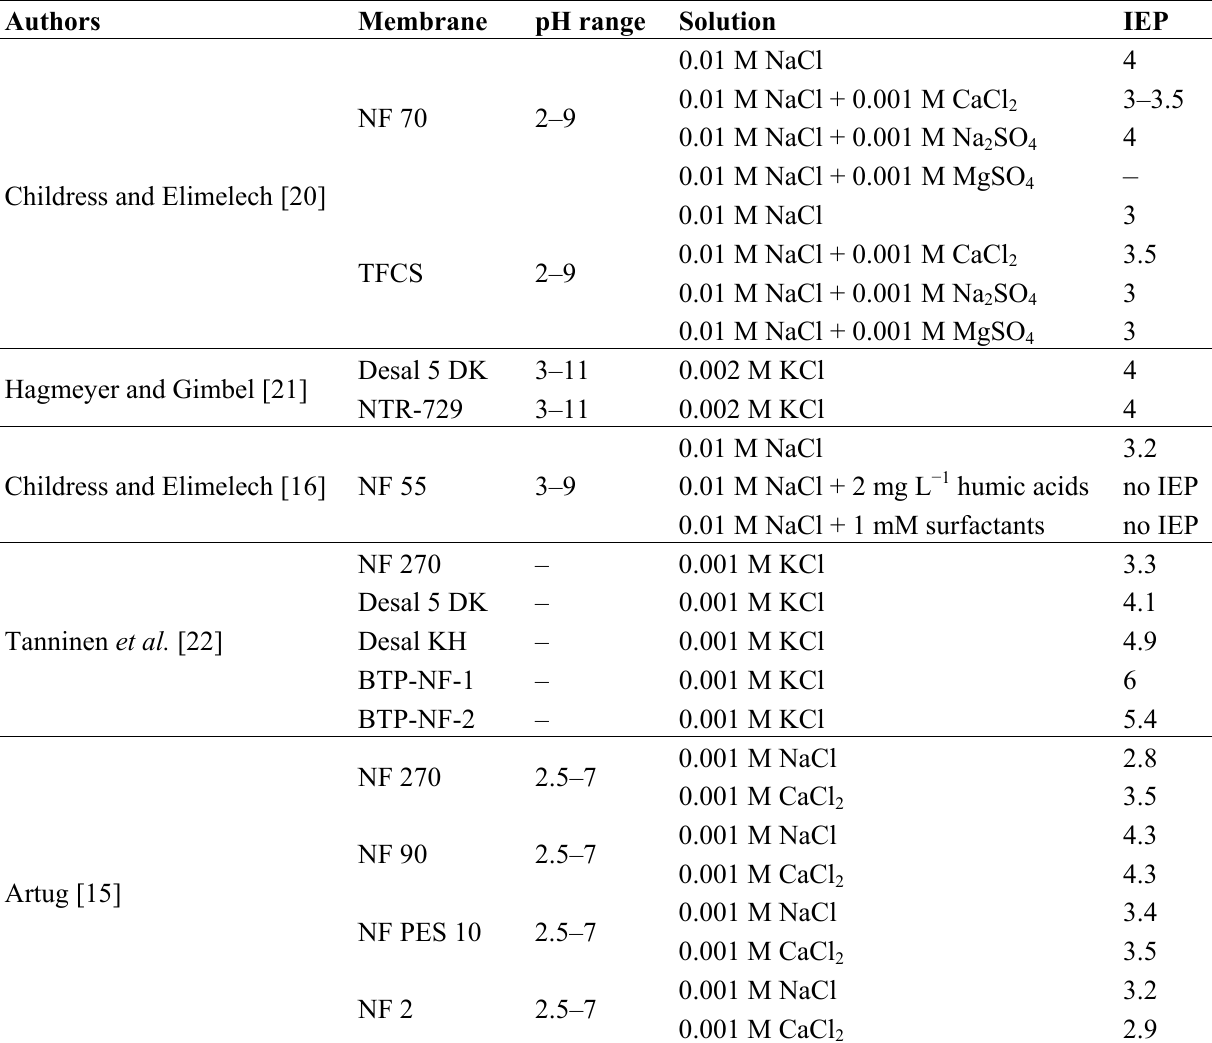
Table 1. Iso-electric point (IEP) of different commercial nanofiltration (NF) membranes as measured in the existing